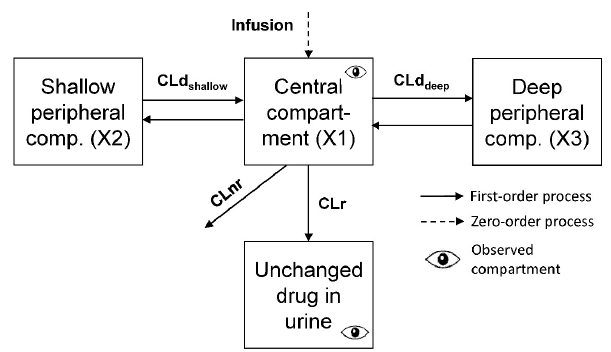
Figure 1. Three-compartment model structure for cefotiam in plasma and urine.